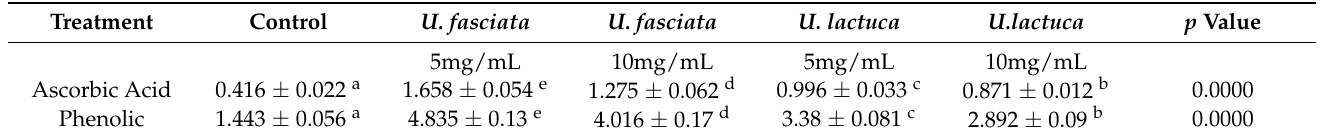
Table 5. Effect of seed priming with different concentrations of soluble polysaccharides on the ascorbic acid content ( µ g/g dry tissue) and total phenolic content (mg/g dry tissue) of Zea mays